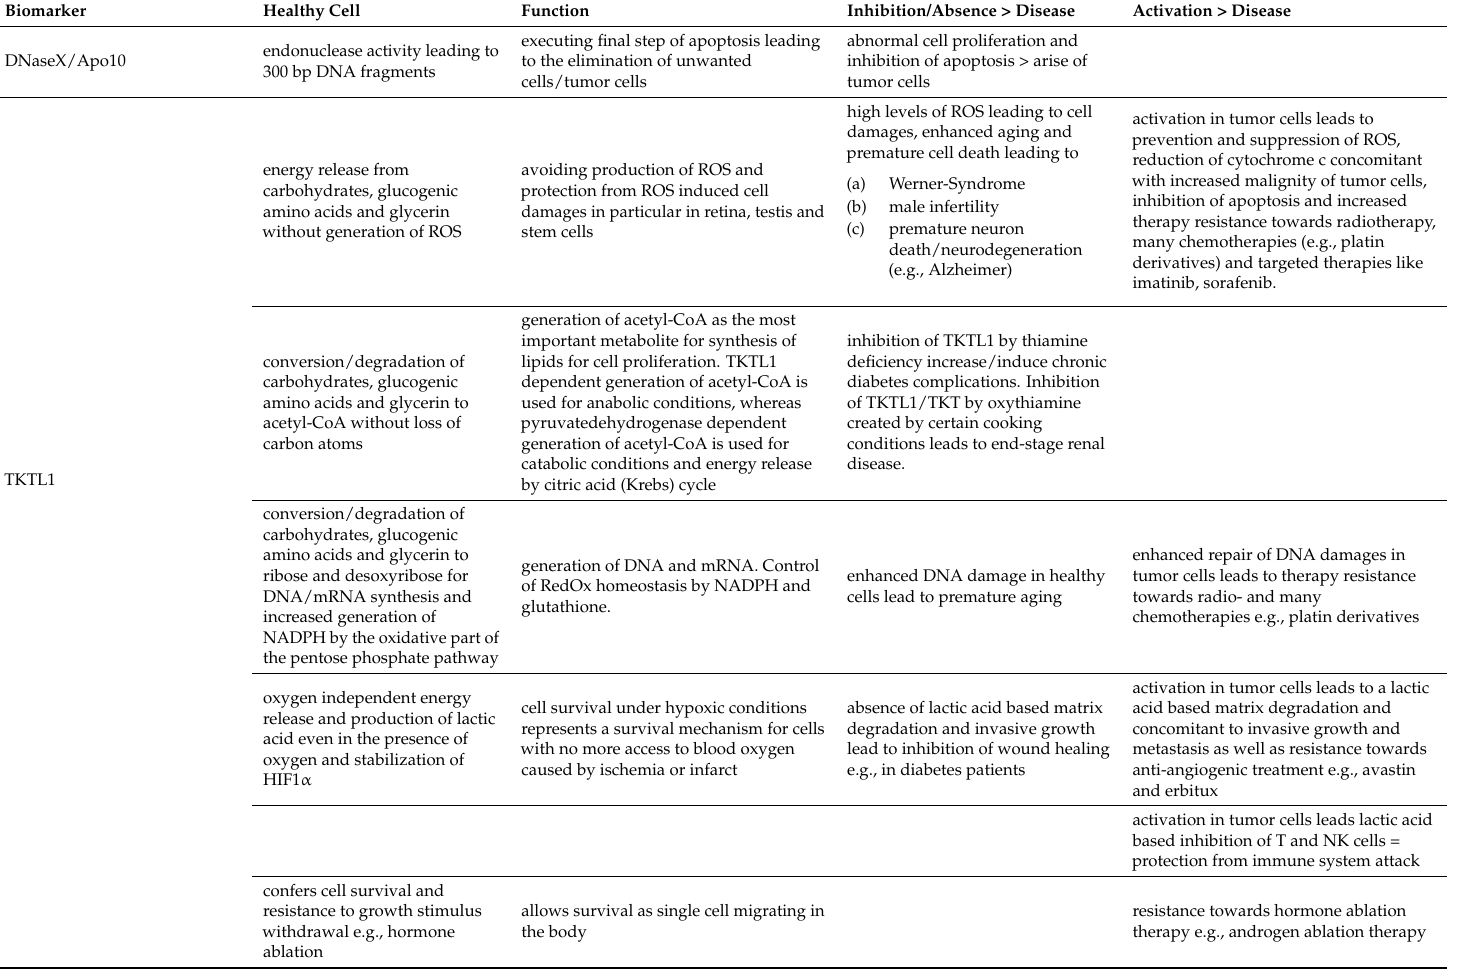
Table 1. The biological role of DNaseX/Apo10 and TKTL1 protein in healthy cells and the impact of activation/inhibition leading to the different